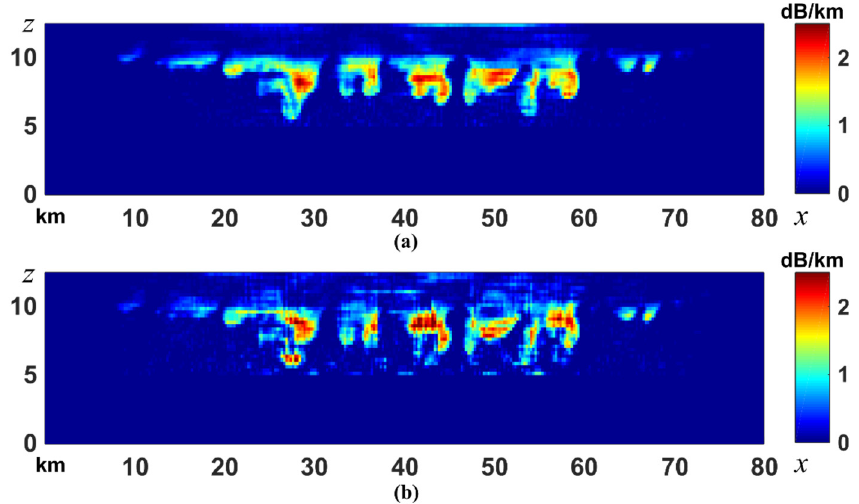
Figure 7. Panel ( a ): The retrieved attenuation field with 37 receivers (distance between two adjacent receivers being 2.5 km) using small basis functions and the same PL function. Panel ( b ): The retrieved attenuation field with 19 receivers (distance between two adjacent receivers being 5 km).